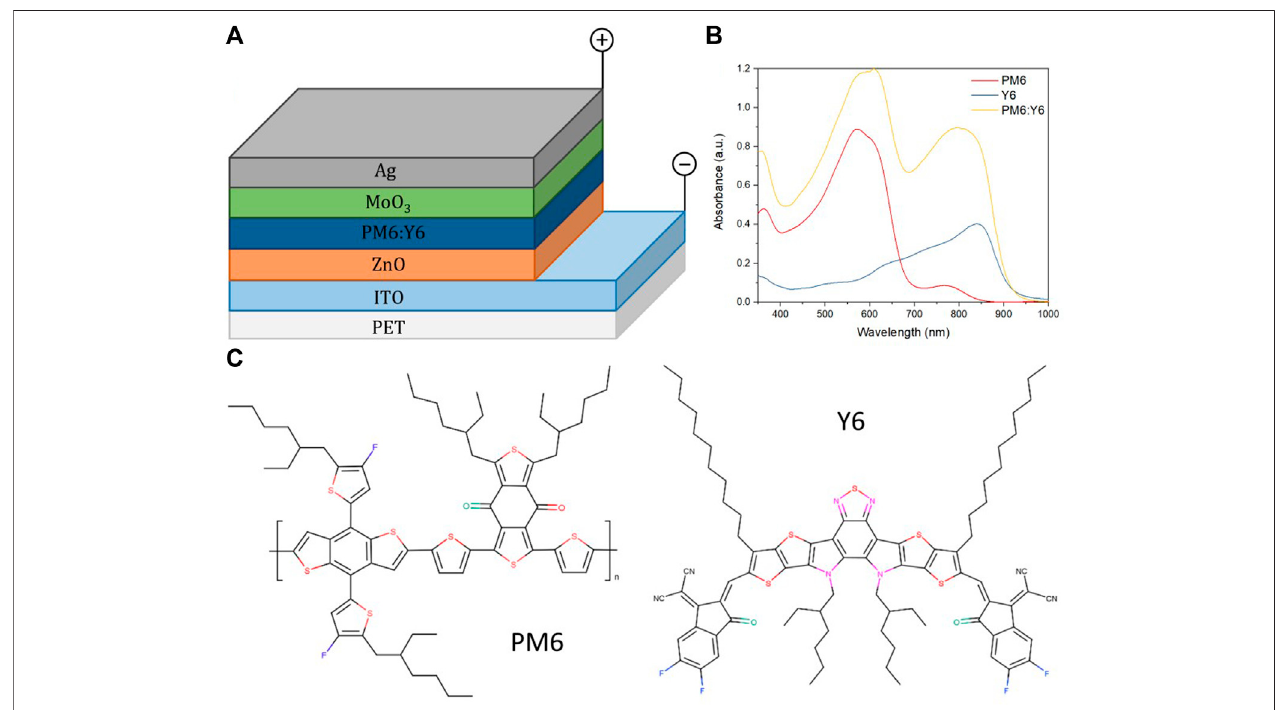
FIGURE 1 | (A) Representation of the inverted OSC used for this study. (B) Absorbance of photoactive materials in o-xylene (16 mg/ml) slot-die coated at 100 ° C. (C) Molecular structures of PM6 and